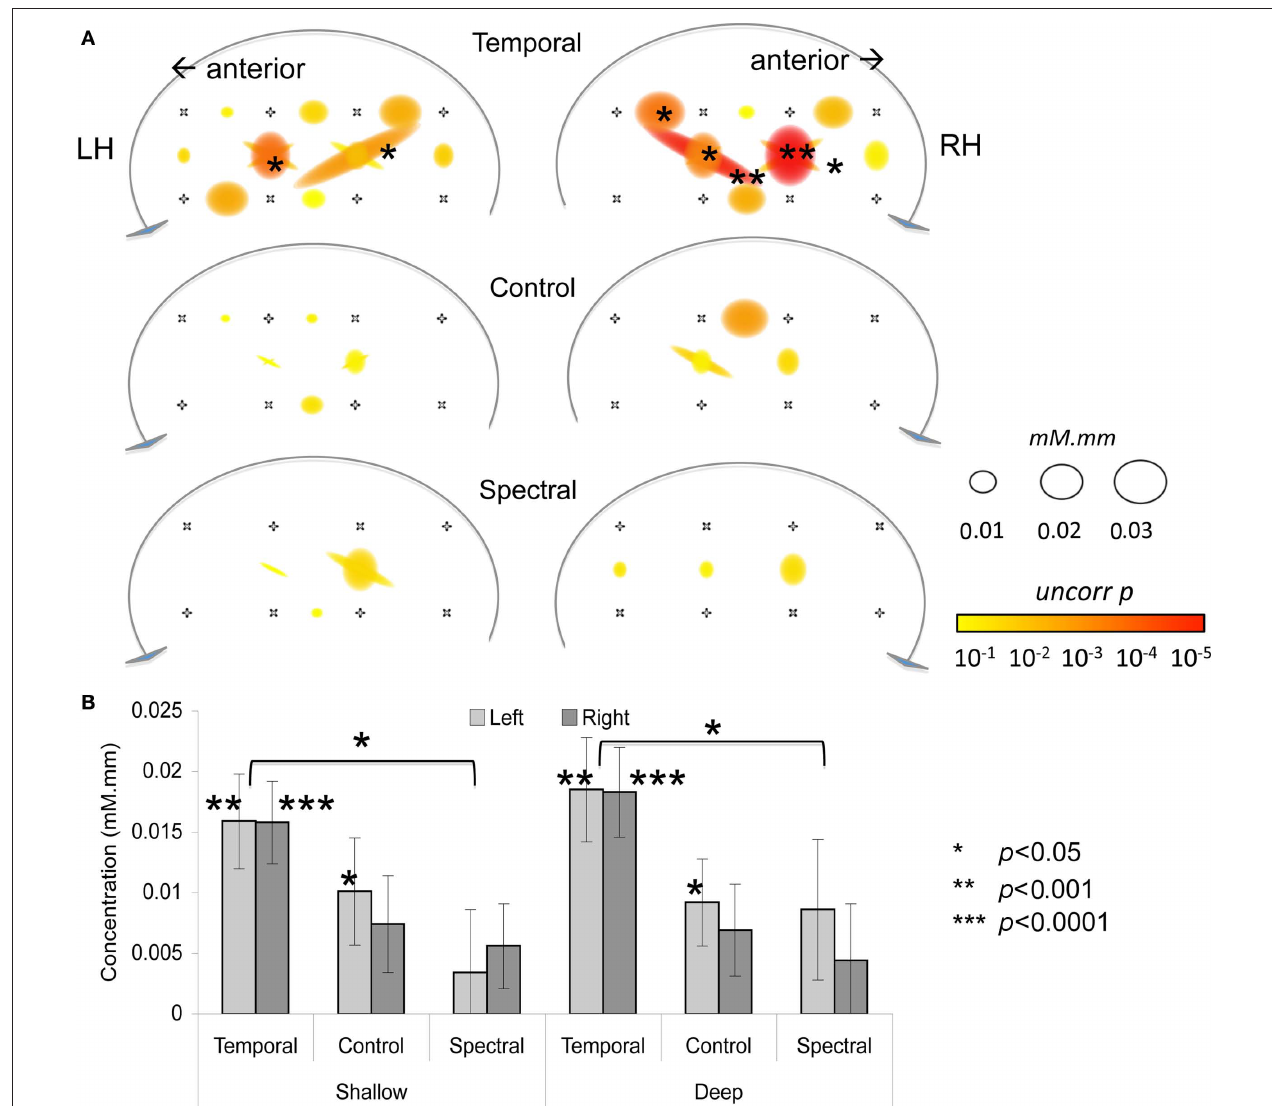
FiguRe 3 | (a) Activation map for three conditions. The size of the circle/oval corresponds to p -value; and the color to β value. (B) Average activation for each condition, as a function of Hemisphere and Depth. Error bars correspond